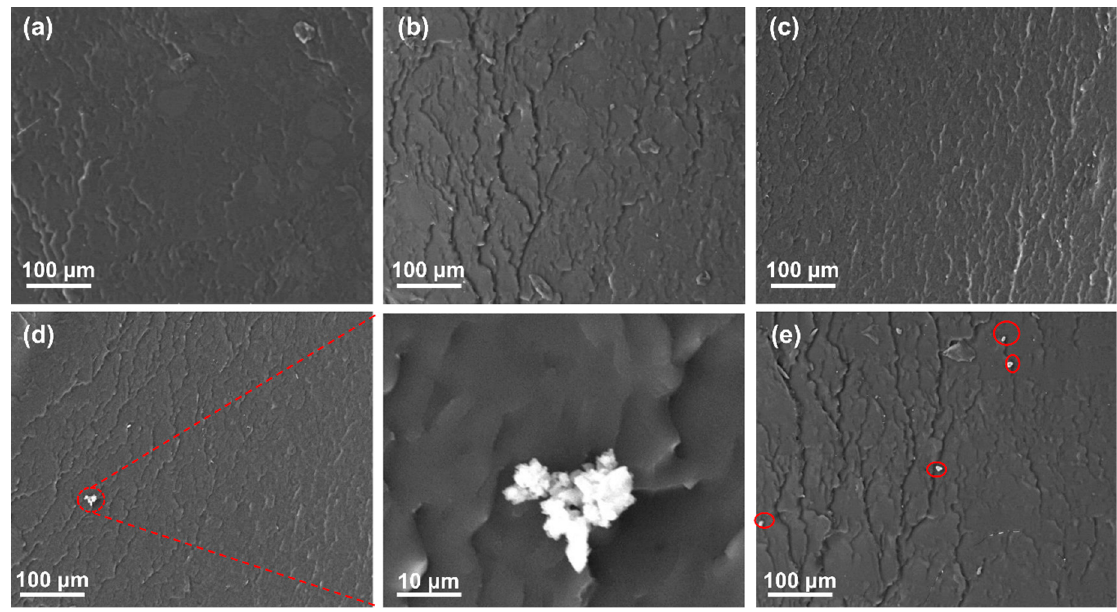
Figure 10. SEM micrographs of fractured nanocomposites filled with different weight parts nano-SiO 2 ( a ) 0, ( b ) 1.0, ( c ) 1.5, ( d ) 2.0 and ( e ) 2.5.